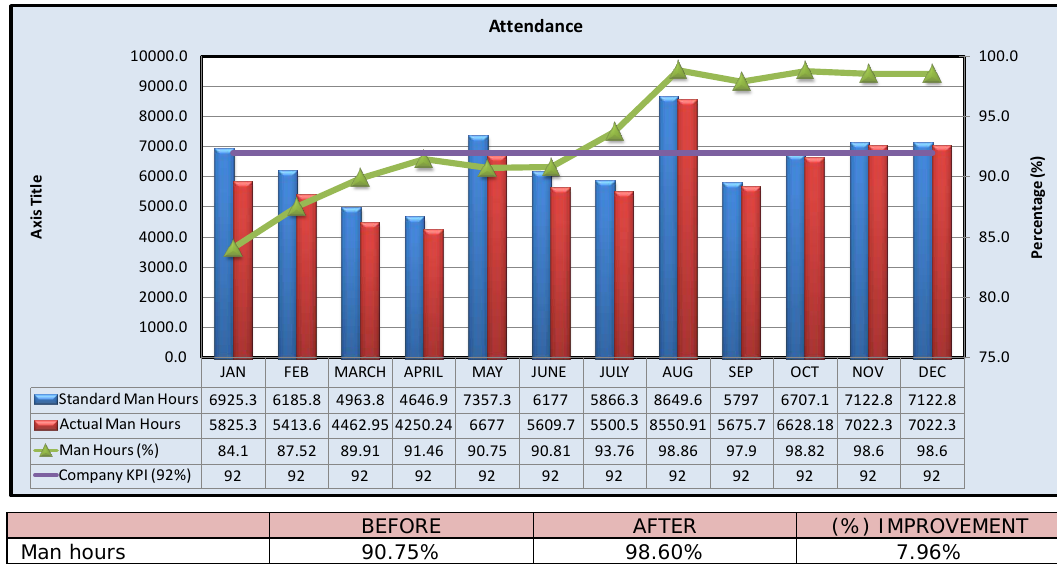
Figure 12. “Attendance Measuring Mechanism Trend and Improvement